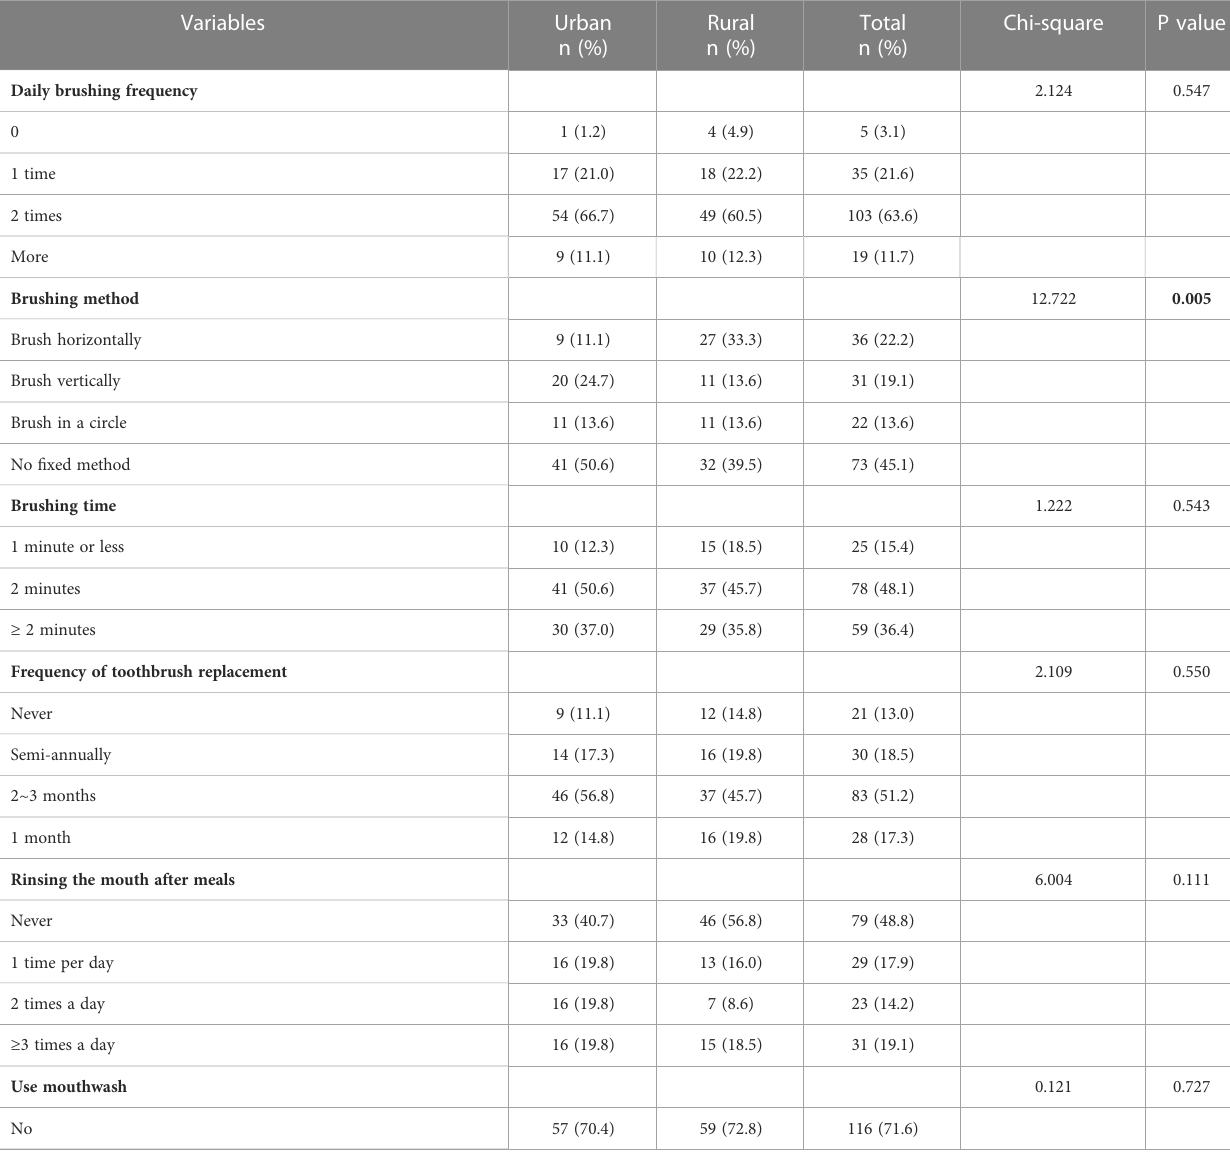
TABLE 2 Oral health behaviors between urban and rural cancer patients. Variables Urban